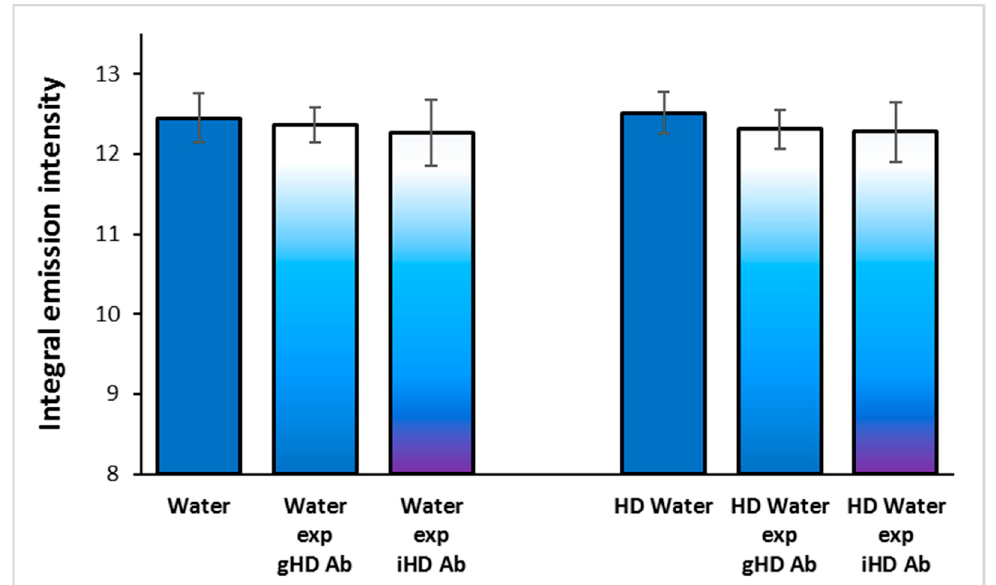
Figure 6. Integral emission intensities of water samples and HD water before and after the non- contact impact of iHD Ab and gHD Ab in the spectral range of 470–2000 cm − 1 . In sample labels, ‘exp’ means ‘exposed to’. Data are presented as mean ± SD.